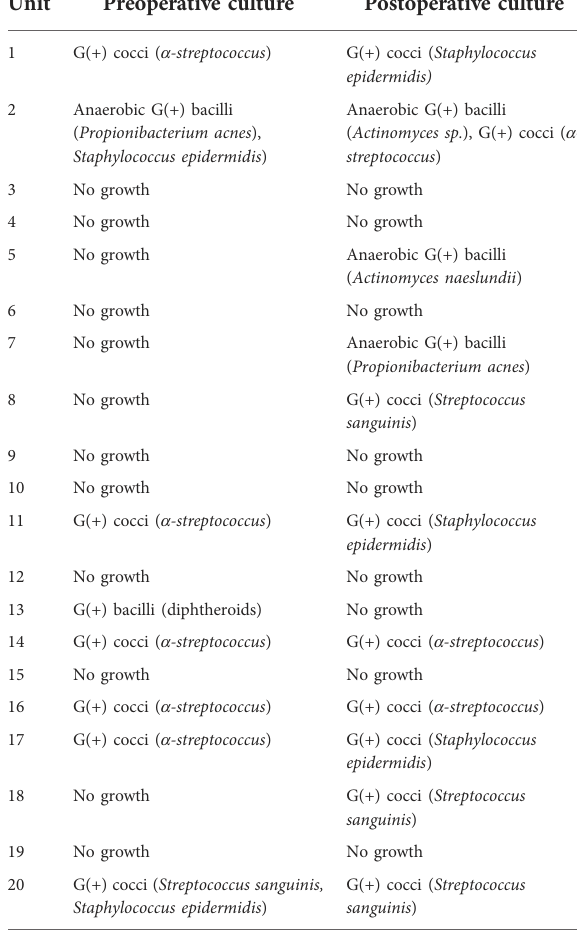
TABLE 3 Details of preoperative and postoperative bacteria culture.